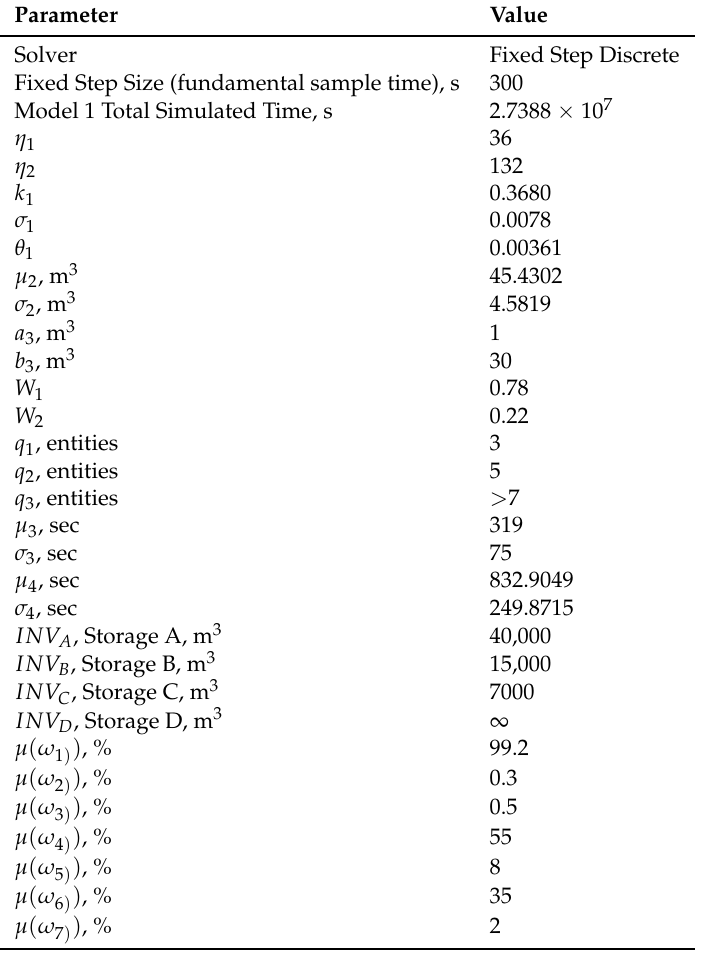
Table 1. Model 1